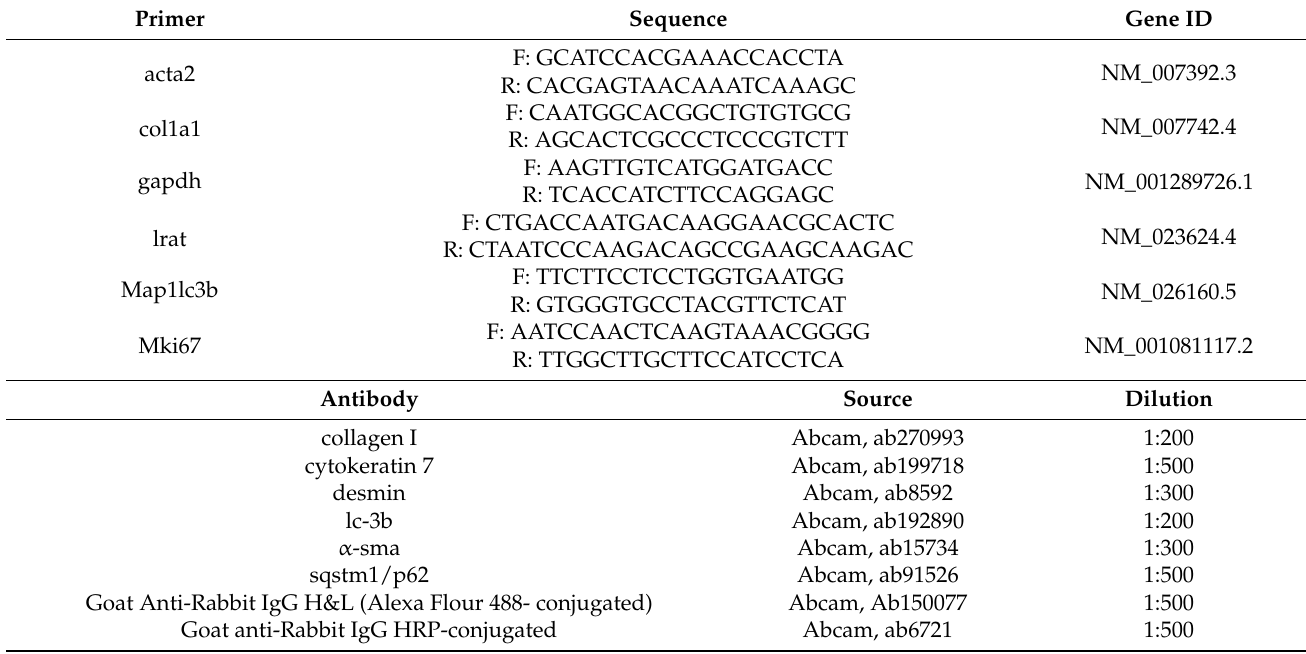
Table 1. Primer sequence and antibody